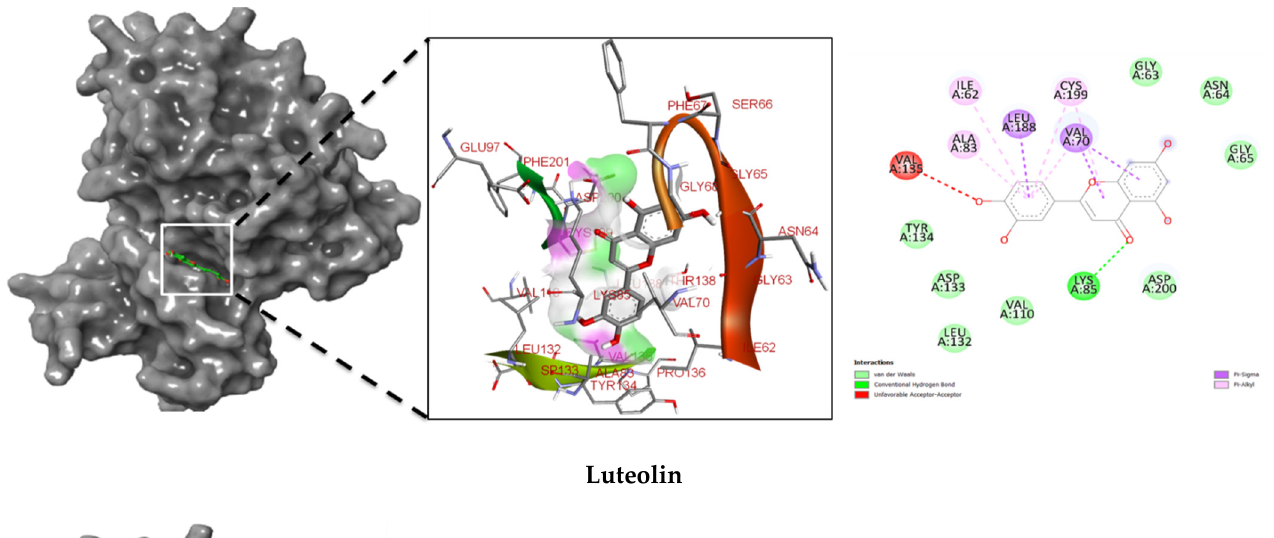
cetin-7-O-neohesperidoside, luteolin, and apigenin) with glycogen synthase kinase 3- β (PDB IDs: 1Q5K), surface view and apigenin) with glycogen synthase kinase 3- β (PDB IDs: 1Q5K), surface view (Left panel), and 2D (Right panel)